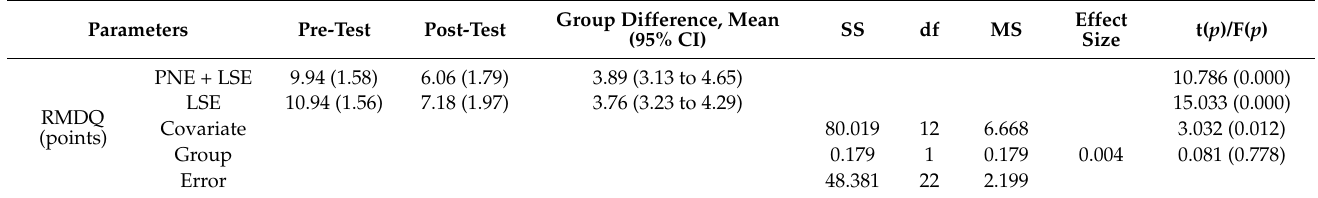
Table 7. Comparison of activity disorder within groups and between groups ( N =